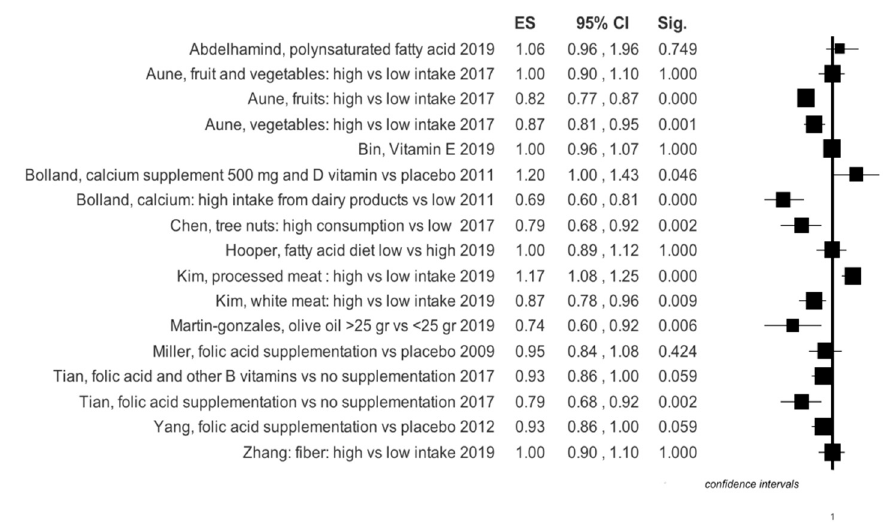
Figure 3. Summary results of effects size for any type of stroke events in observational studies, based on study design of selected primary studies for each meta-analysis.